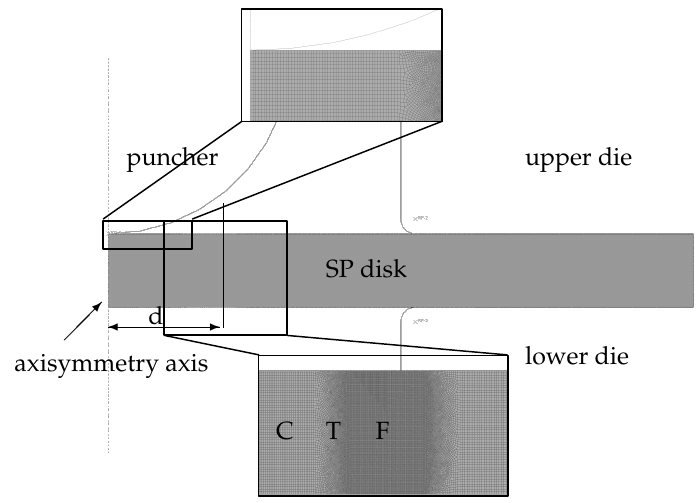
Figure 3. Axisymmetric finite element model and the mesh used for 0.5 mm thick disk: F-Fine, T-Transition, C-Coarse Mesh Regions. The width of the T + F is approximately 0.6 mm and the distance of this region from the center of the disk, d, is 0.7 mm. (minimum element size: 1.5 × 2.5 µ m, number of elements: 59,143). The same meshing pattern is applied to the disks with other